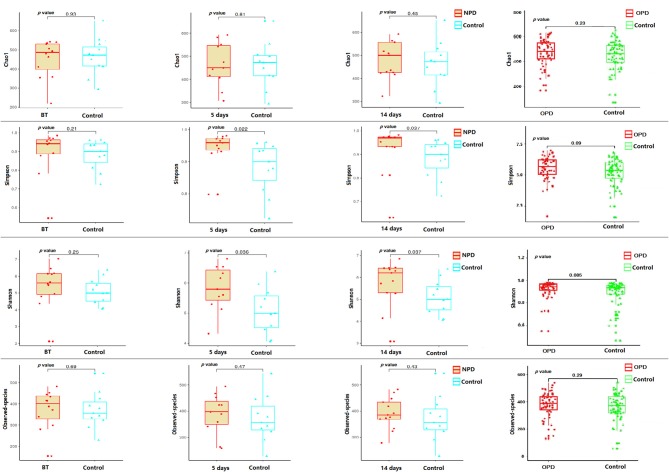
α-diversity indices of the fecal microbiome in the PD and their corresponding HC groups. Box plots depicting differences in the fecal microbiome diversity indices between the NPD, OPD, and HC groups according to the Chao1 index, observed species index, Shannon index, and Simpson index based on the OTU counts. No statistically significant differences were found with respect to commonly used α-diversity indices between the NPD, OPD, and HC groups. Each box plot represents the median, interquartile range, minimum, and maximum values. BT, before treatment. P level is corrected for multiple comparisons.